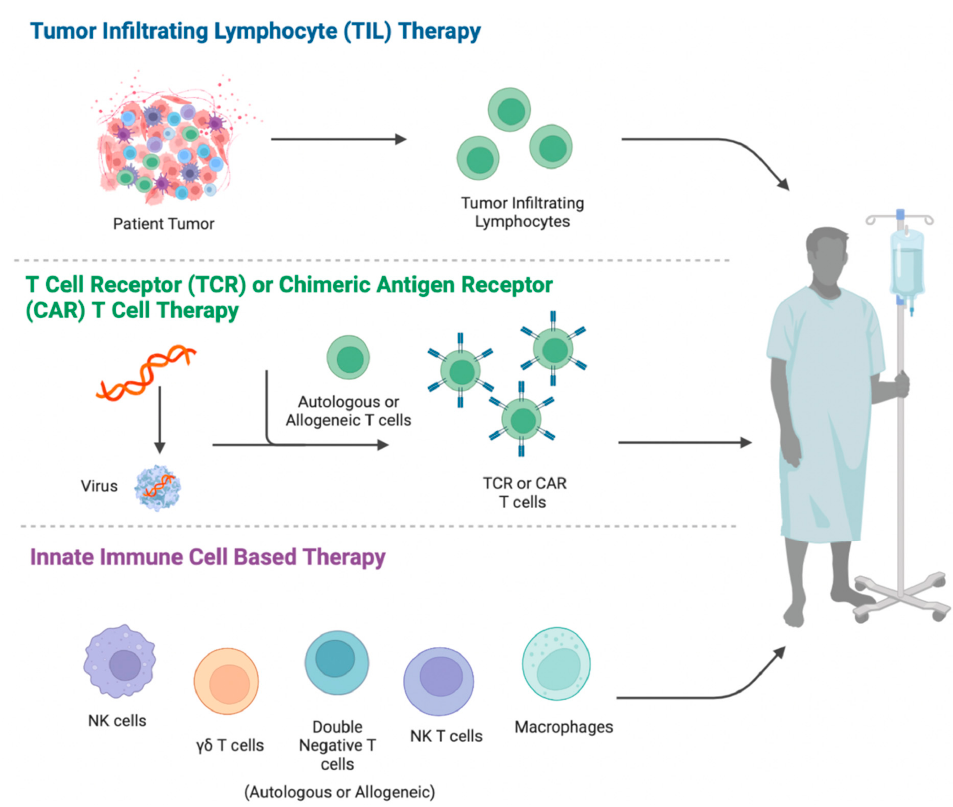
Figure 1. Types of adoptive cell therapy.